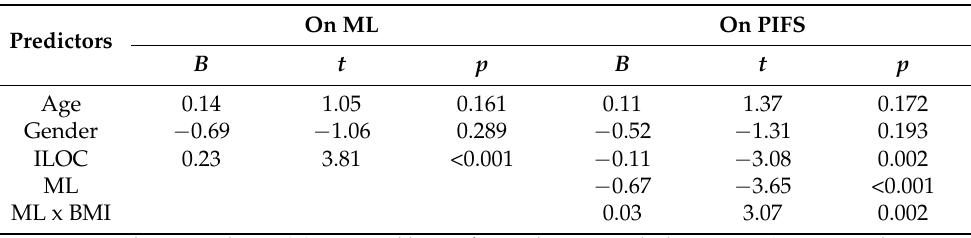
Table 3. The moderated mediating effect of internal locus of control on the perceived effect of fitspiration images on self.